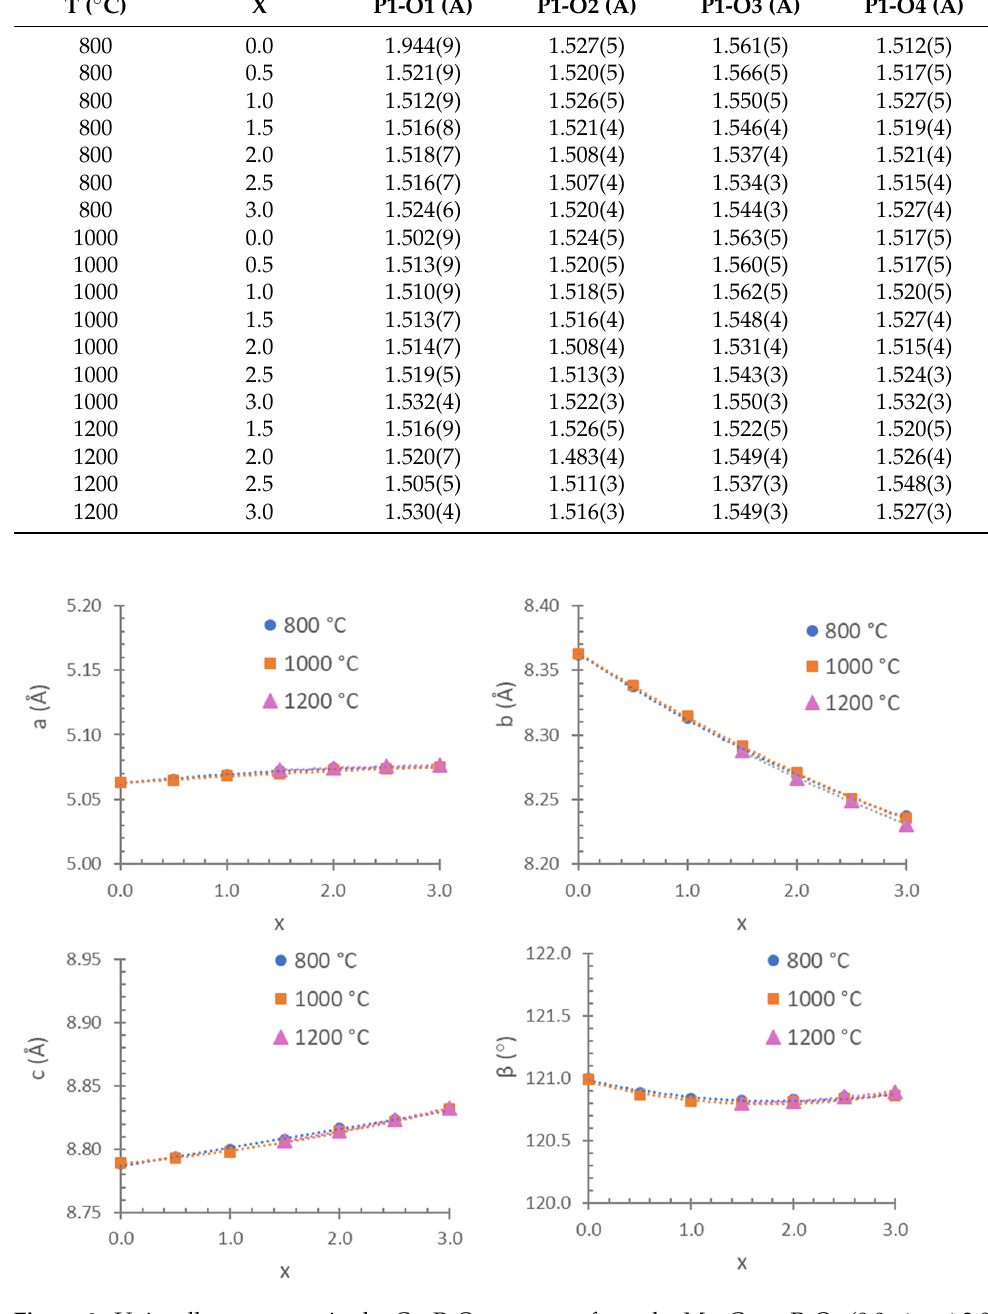
Figure 3. Unit cell parameters in the Co 3 P 2 O 8 structure from the Mg x Co 3 − x P 2 O 8 (0.0 ≤ x ≤ 3.0) compositions fired at 800, 1000 and 1200 °C. Table 3. Variations in the M-O (M = Co, Mg) distances in the stable Co 3 P 2 O 8 structure with temper- ature in the Mg x Co 3 − x P 2 O 8 compositions.